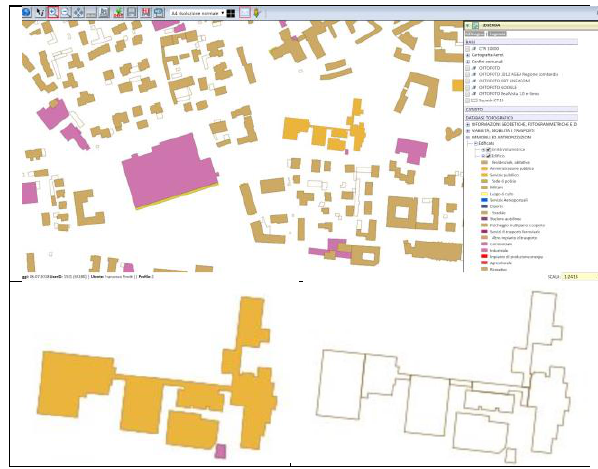
Figure 9. Top: representation of the two chosen layers with building representations. Bottom left: “edificio” (building). Bottom right: “unità volumetrica” (volumetric